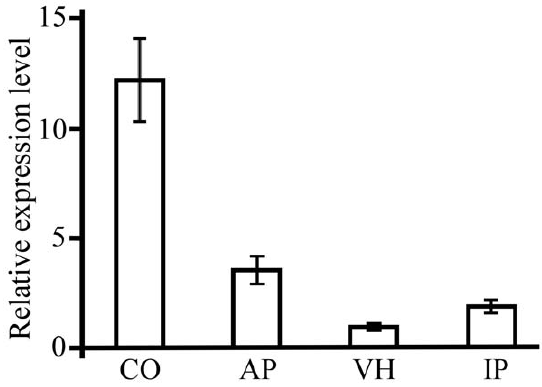
Figure 8. Expression of MoSFL1 in different developmental stages. RNA samples used for qRT-PCR assays were isolated from conidia (CO), appressoria (AP), vegetative hyphae (VH), and infected plants (IP). The relative expression level of MoSFL1 was compared to that of the VH stage (arbitrarily set to 1). Mean and standard error were calculated with data from three biological replicates.